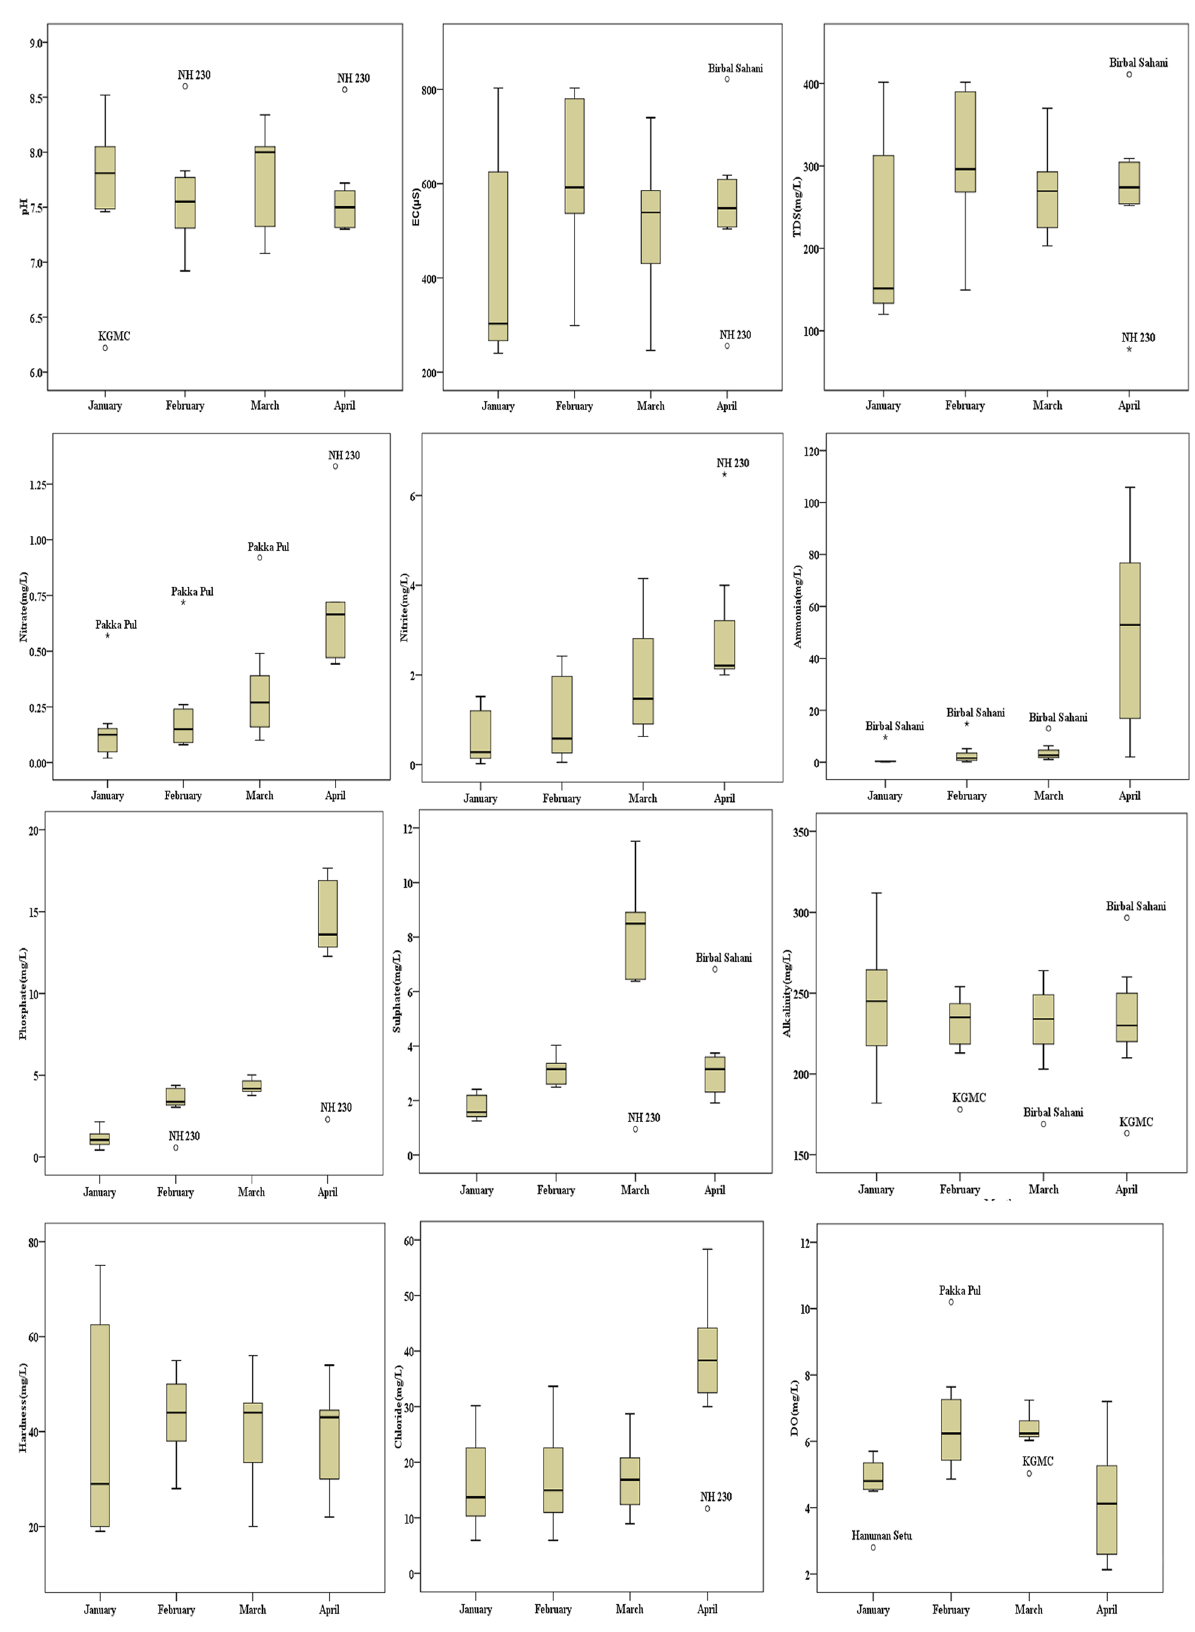
Fig. 3 Box and whisker plots of the physiochemical